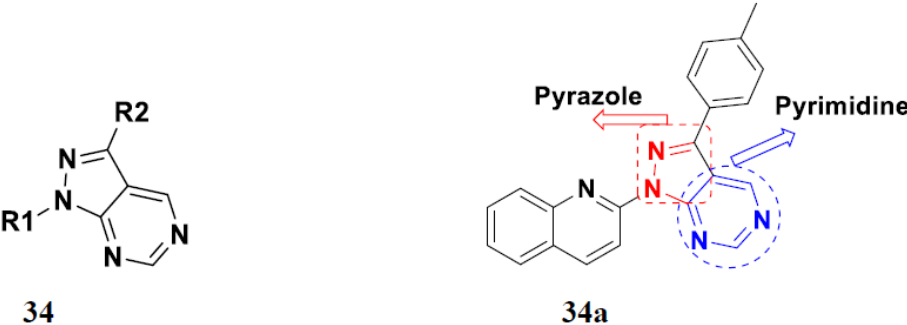
Figure 37. Structure of pyrimidine-pyrazole based hybrids and the most promising compound 34a . Table 27. In vitro cytotoxic activities of pyrimidine-pyrazole based hybrid compounds 34 ( b – e ). Compound